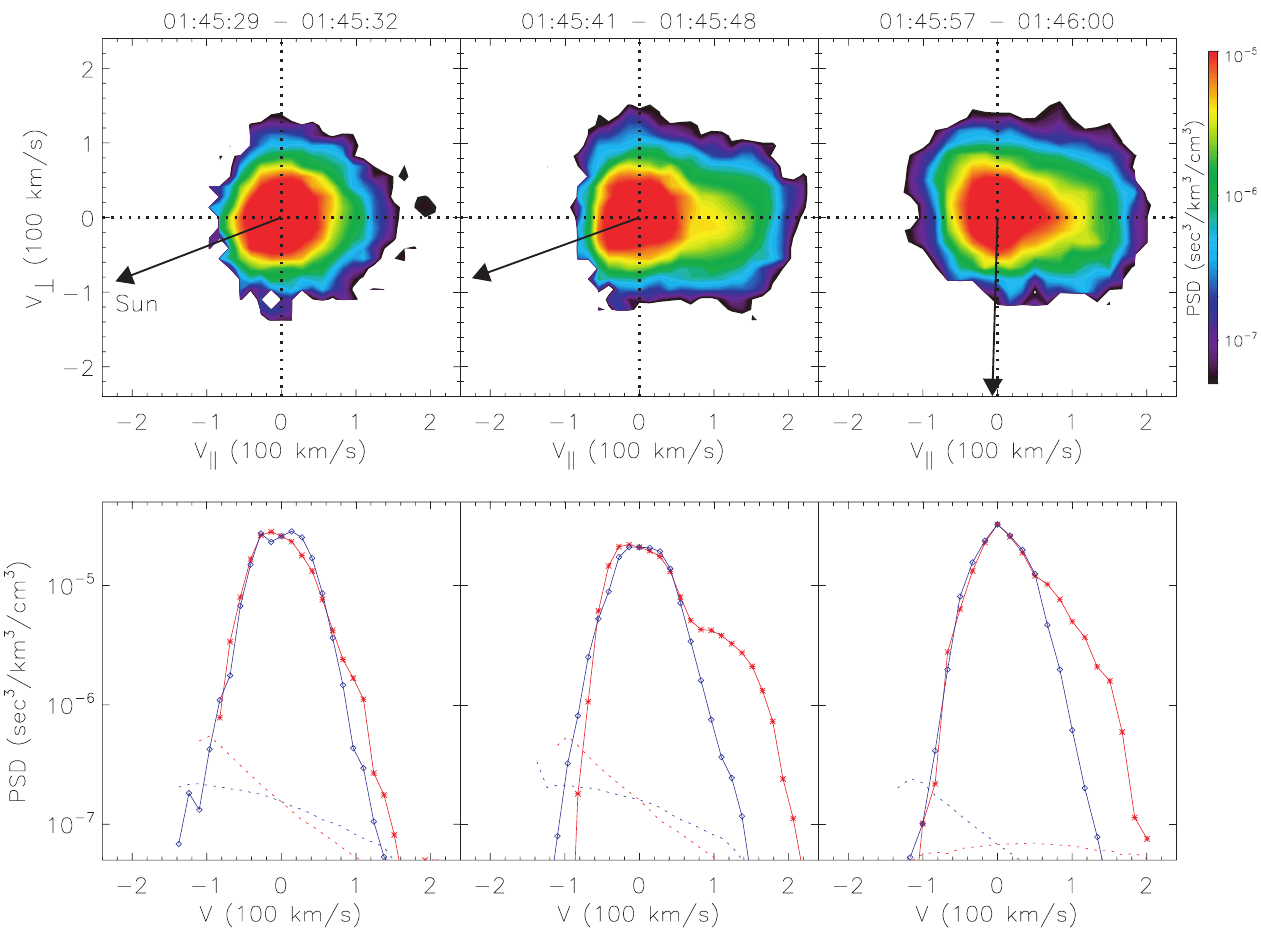
Fig. 3. Wind 3D-P PESA-L ion distribution functions (left) just outside the reconnection region at 01:45:29UT; (middle) within the front separatrix region from 01:45:41 to 01:45:48 (average of two consecutive distributions); (right) in the outflow region at 01:45:57. Data are presented in the solar wind frame and in the magnetic field coordinate system. The top panels show the 2-D distributions in the plane [ v k ,v ⊥ ] ( v k and v ⊥ being the velocities in the direction parallel and perpendicular to the local magnetic field). The direction to the Sun (basically the Sun-Earth direction) is indicated by an arrow. The color coding indicates the amplitude of the distribution function in units of s 3 km − 3 cm − 3 . Cuts of the distributions along the direction parallel (in red) and/or perpendicular (in blue) to the magnetic field are shown on the bottom panels. The dashed lines represent the one-count level